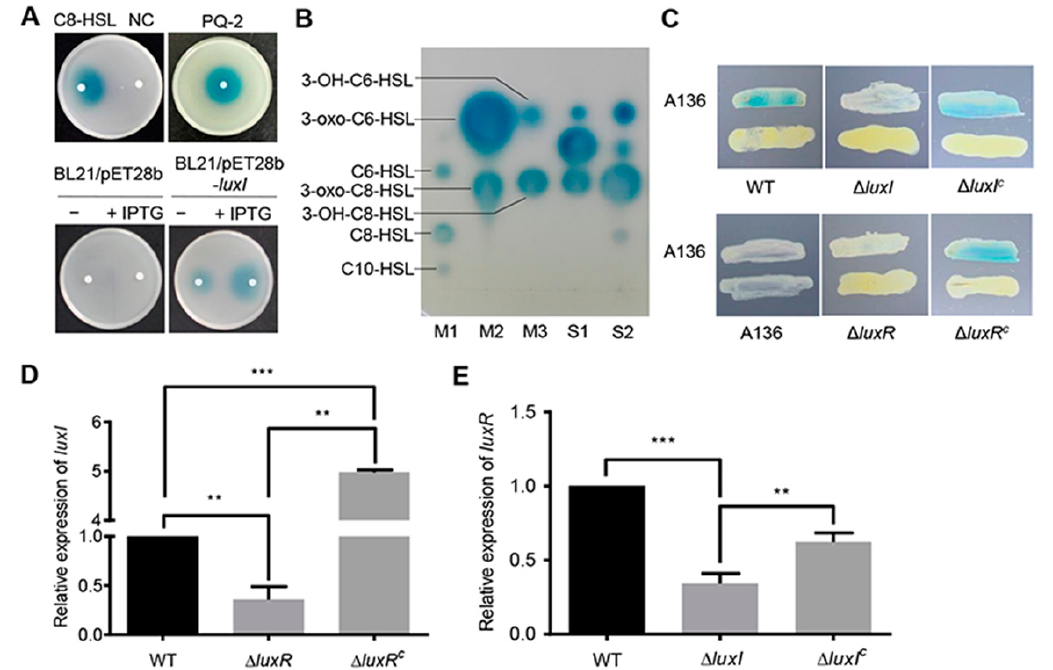
Figure 1. Identification of the LuxI/LuxR QS system. ( A ) Analysis of AHLs using the biosensor strain A. tumefaciens A136. AHLs were extracted from culture supernatants of C. naphthovorans PQ-2, E. coli BL21 harboring pET-28b(+) (BL21/pET28b) or pET-28b(+) expressing luxI (BL21/pET28b- luxI ). C8-HSL and acidified ethyl acetate were used as positive control and negative control (NC), respectively. ( B ) Identification of AHLs by TLC. M1~M3, standard AHLs; S1, AHLs extracted from PQ-2; S2, AHLs extracted from E. coli BL21 expressing luxI . ( C ) Cross-feeding bioassay for detection of AHLs in C. naphthovorans strains. ∆ luxI C and ∆ luxR C represent the complemented version of ∆ luxI and ∆ luxR , respectively. ( D , E ) Relative expression levels of luxI ( D ) and luxR ( E ). The transcription level of the wild type was defined as 1.0. Experiments were performed in three biological replicates, and similar trends were observed. The representative data from three separate experiments are shown. Statistical significance of di ff erences was analyzed by t -test; **, p < 0.01; ***, p < 0.001.